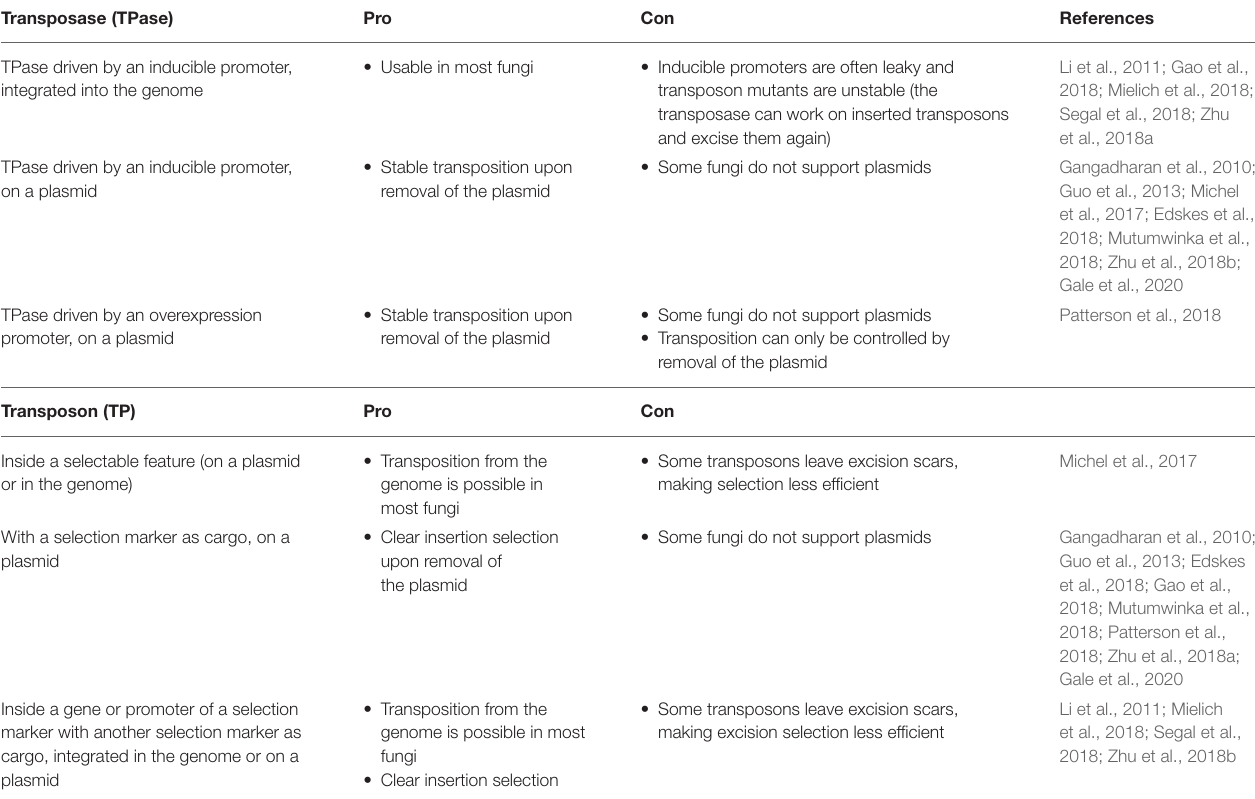
TABLE 2 | Transposon strategies in fungi. Transposase (TPase) Pro